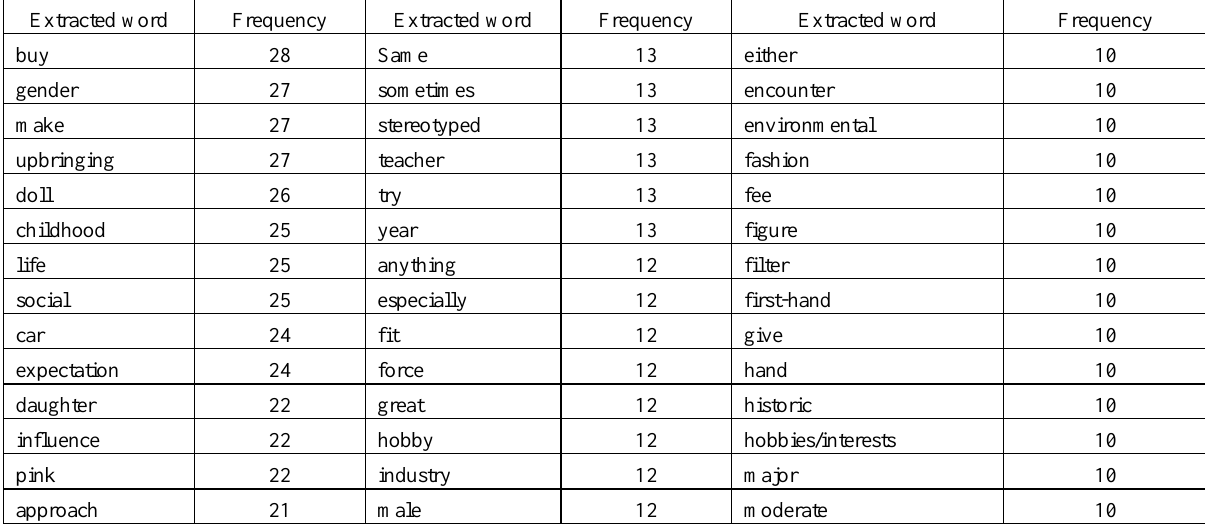
Table 8 (cont.). List of top words collected from open-ended fields